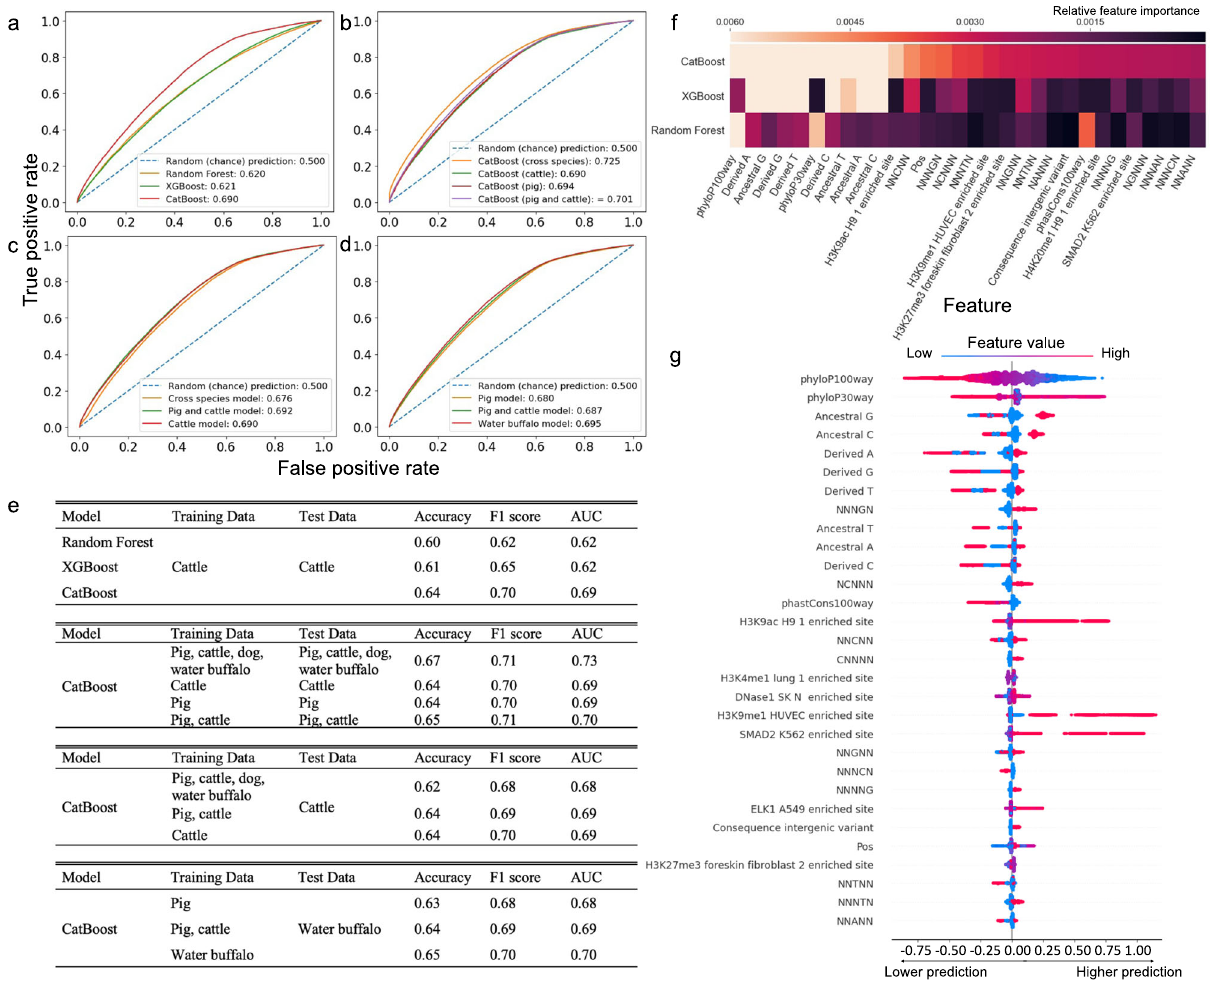
Fig. 3 Machine learning models of orthologous variants. a Receiver operating characteristic (ROC) curves of Random Forest, XGBoost and CatBoost models trained and tested using human variants with and without orthologues in cattle. The numbers in the legend are area under the receiver operating characteristics (AUC) scores of the different models. AUC re fl ects a model ’ s general ability of distinguishing between the classes, the closer to 1 the better the model performance. Values of 0.5 would re fl ect a model not able to differentiate between variants with and without orthologues. b ROC curves of CatBoost models trained and tested using human variants with and without orthologues in cattle; pig; pig or cattle; pig, cattle, dog or water buffalo (cross species). c ROC curves of CatBoost models trained using human variants with and without orthologues in cattle; pig or cattle; pig, cattle, dog or water buffalo, but tested using human variants with and without orthologues in cattle. d ROC curves of CatBoost models trained using human variants with and without orthologues in pig; water buffalo; pig or cattle, and tested using human variants with and without orthologues in water buffalo. e Summary statistics of the experiments. Tables correspond to the same analyses shown in plots A to D respectively in the same order. f Feature heatmap of CatBoost, XGBoost, Random Forest models trained and tested using human variants with and without orthologues in cattle. Thirty important features are included in the fi gure, with lighter color indicating greater importance in that model. g SHAP summary plot 52 of the CatBoost model trained using human variants with and without orthologues found in any of cattle, pig, dog and water buffalo. A SHAP plot shows the relationship between feature values and their impact on model predictions. Features are ranked in descending order according to their importance on the left. The color represents low (in blue) and high (in red) value of the feature and the effect of their values on the output of the model is re fl ected by their positions on the x-axis. For example, lower phyloP100Way conservation scores (as indicated in blue) are associated with an increased probability of a human variant having an orthologue in another species (being higher on the x axis). The SHAP values underlying this plot can be downloaded from. The data underlying Fig. 3 can be downloaded from